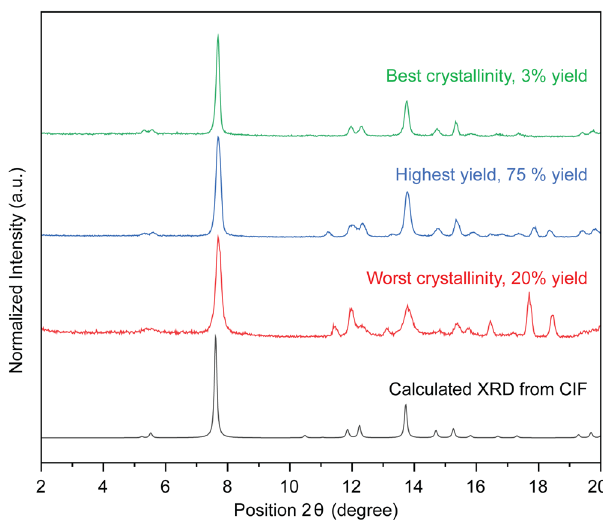
Fig. 4 Best and worst PXRD patterns obtained in generation 2. PXRD of the best (highest crystallinity and yield) and worst crystallinity produced from the second generation of experiments, as well as the calculated XRD from the CIF of